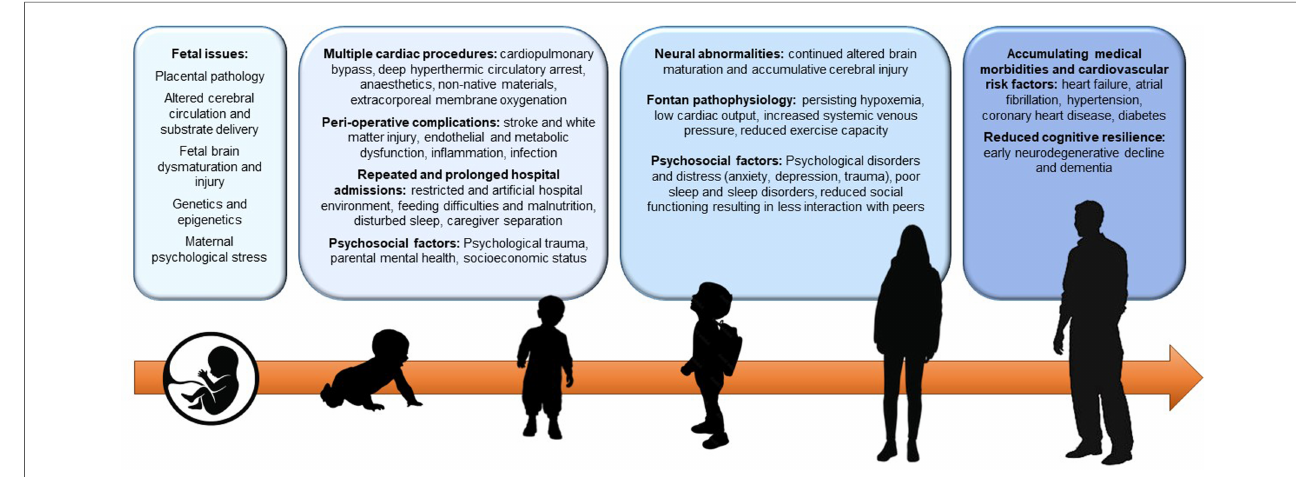
FIGURE 1 Accumulative neurodevelopmental and cognitive risk factors across the lifespan.